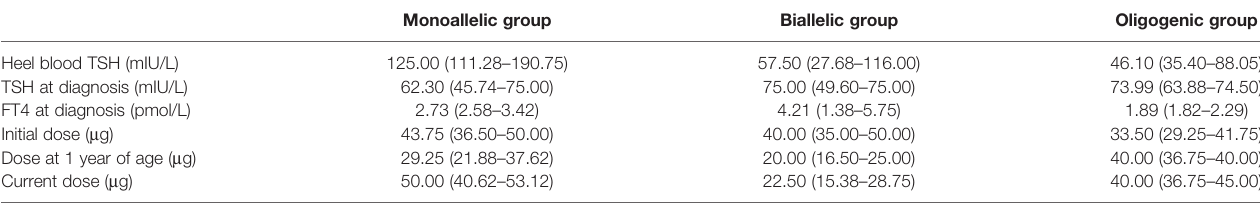
TABLE 5 | Comparison of the clinical characteristics in the monoallelic, biallelic, and oligogenic